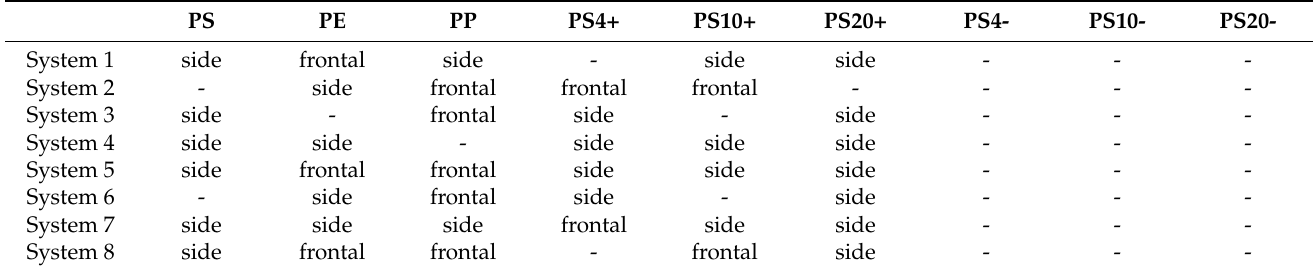
Figure 5. Structural effects of the protein – NP interaction. ( A ) Beta-sheet content of the fibril struc- 240 ture, showing that the interaction with the NPs does not significantly alter the beta-sheet content of 241 Table 1. Type of contact for the different NP–fibril the fibril. The shape factors of the NPs ( B ) at the start and the end of the simulations show that the 242 interaction with the amyloid fibril does not lead to major changes in the shape of the NPs, although 243 the NPs assume a more elongated structure, as shown by the increasing SF.